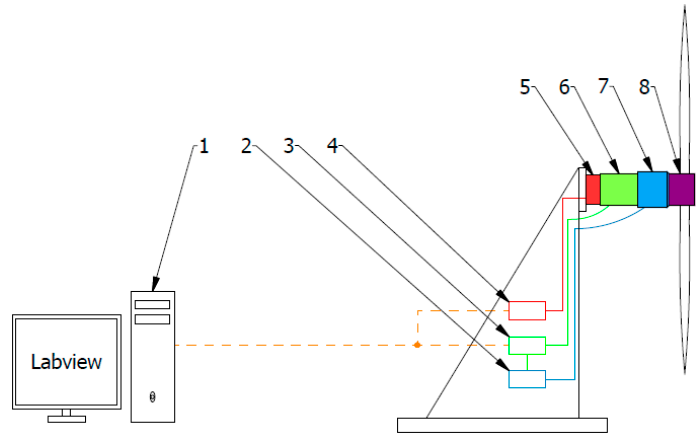
Figure 1. Scheme of the measuring station for testing forces and moments for different stroke settings: 1-Computer with Labview software; 2-Motor controller HOLYBRO ESC TEKKO32 35A; 3-Variable pitch propeller controller; 4-Measuring card ATI FTIFPS1 SI-40-2; 5–6-axis force and torque sensor F/T Sensor Mini40; 6-Servo drive of the variable pitch propeller mechanism; 7-Motor Mad 5008 from Mad Components and 8-Variable pitch propeller mechanism.